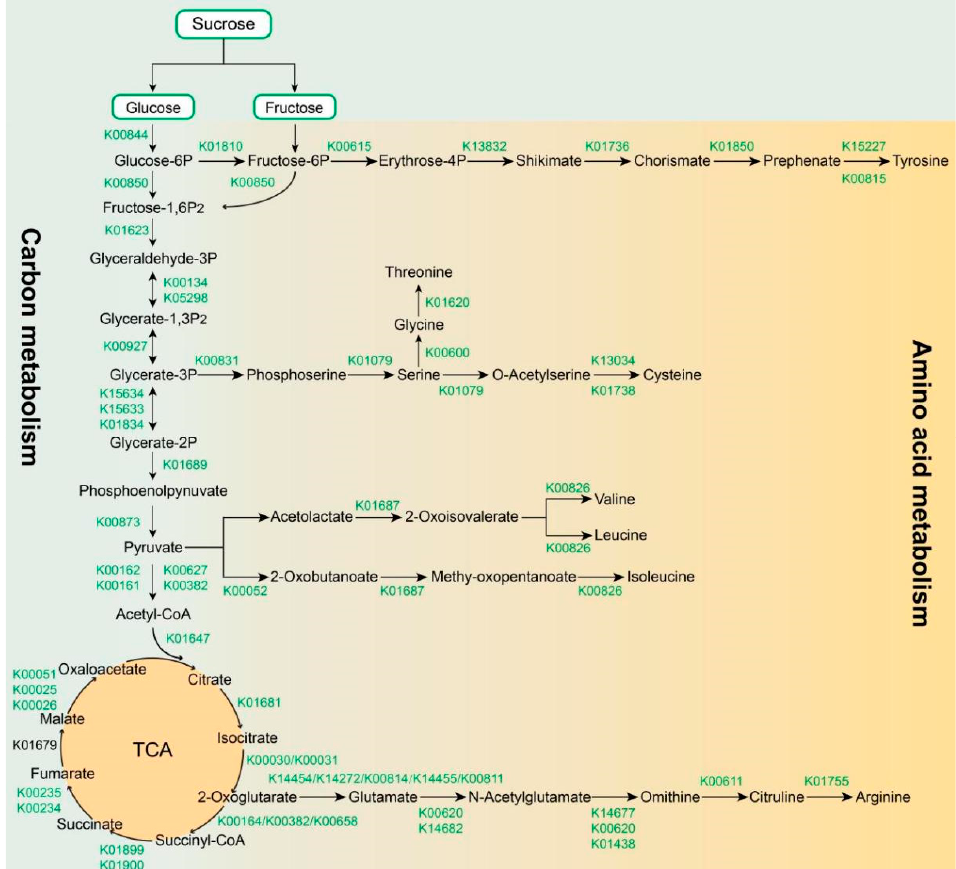
Figure 3. Carbohydrate metabolism (Ko01200) and amino acid metabolism pathways (Ko01230) in A. arguta cv. Qinziyu were adapted from the Kyoto Encyclopedia of Genes and Genomes (KEGG) pathway, available online (http://www.genome.jp/kegg/pathway.html, accessed on 10 October 2022).